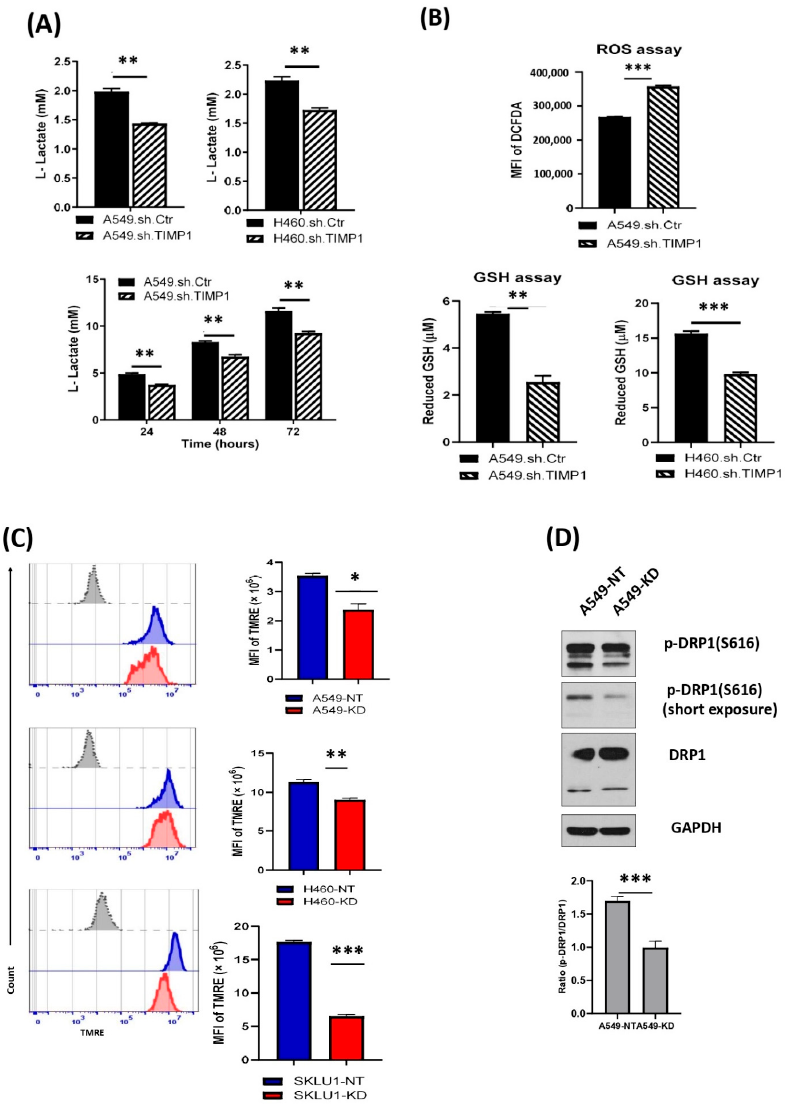
Figure 2. TIMP-1 modulates’ metabolic profiles in NSCLCs. ( A ) NSCLC cells (A549 and H460) derived TIMP-1 non-target (NT) control and knockdown (KD) clones were cultured in complete medium for three consecutive days. Supernatants were collected at 0, 24, 48 and 72 h. Equal volumes of supernatants were applied to measure L-lactate production at same indicated time points with glycolysis assay. Cell attachment time was defined as the 0 h of time point. ( B ) Logarithmically growing NSCLC cells (A549) derived TIMP-1 NT, and KD clones were incubated with DCFDA solution. The cellular ROS levels were measured by mean of the mean fluorescence intensity (MFI) of DCFDA by flow cytometry. Total reduced-glutathione (GSH) was quantitatively determined with NSCLC cells (A549 and H460) derived TIMP-1 NT and KD clones by GSH/GSSG assay. ( C ) The active mitochondrial membrane potential in live NSCLC cells (A549, H460 and SKLU1)-derived TIMP-1 NT and KD clones were labeled with TMRE (tetramethylrhodamine and ethyl ester) and measured by flow cytometry (grey, isotype control; blue, NSCLC cells derived non-target (NT) control; red, NSCLC cells derived TIMP-1 knockdown (KD) clones). ( D ) Mitochondrial fission-required DRP1 protein expression level was detected with NSCLC cells (A549) derived TIMP-1 NT and KD clones cell lysates by Western blot. Data were quantified by densitometry using ImageJ and normalized to reference genes as loading control. Data representative of three ( A , B , D ) and two ( C ) independent experiments. Statistical significances are indicated by * p < 0.05; ** p < 0.01; *** p <